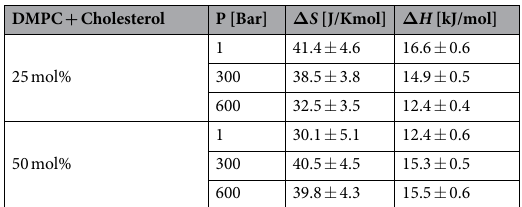
Table 3. Thermodynamic parameters for DMPC + cholesterol at two different concentrations extracted from EINS. The absolute error on pressure is ± 30